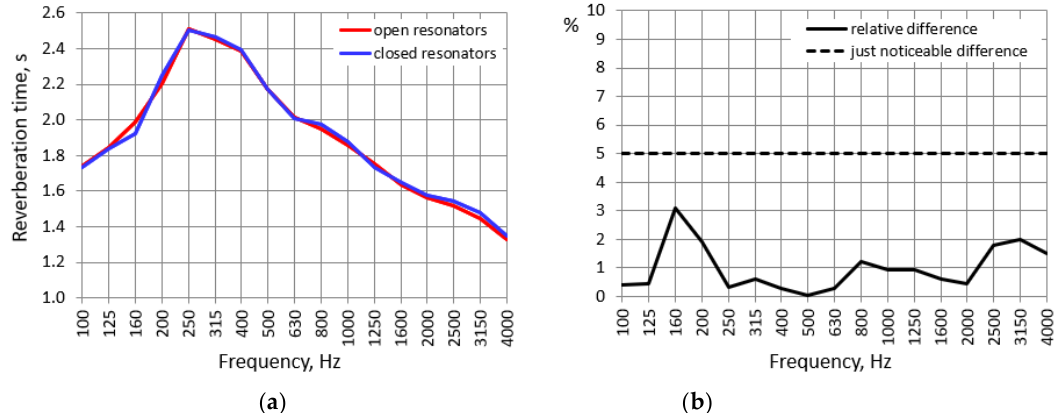
Figure 10. Reverberation time in the Rachmaninov Hall measured with open and closed resonators ( a ), the relative difference 𝛿 the reverberation time ( b ).